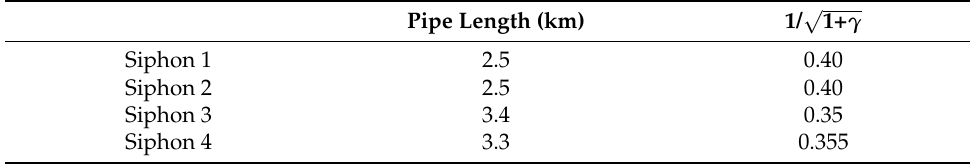
Table 2. Siphon parameters.